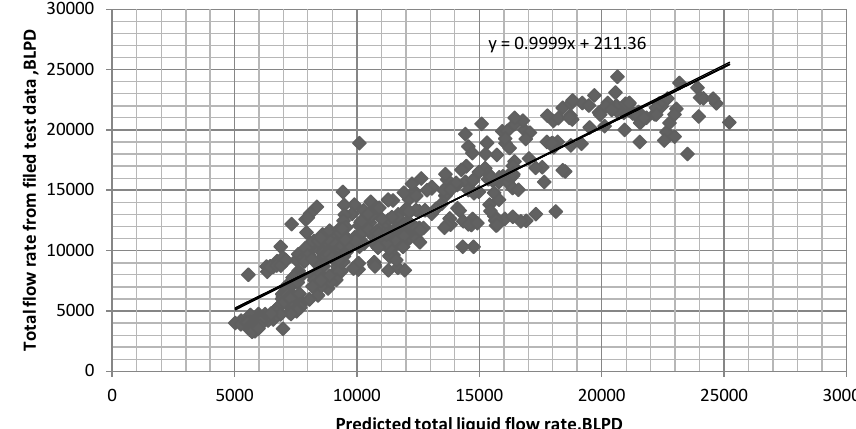
Figure 1. Predicted vs. measured flow rates for the first derived correlation.